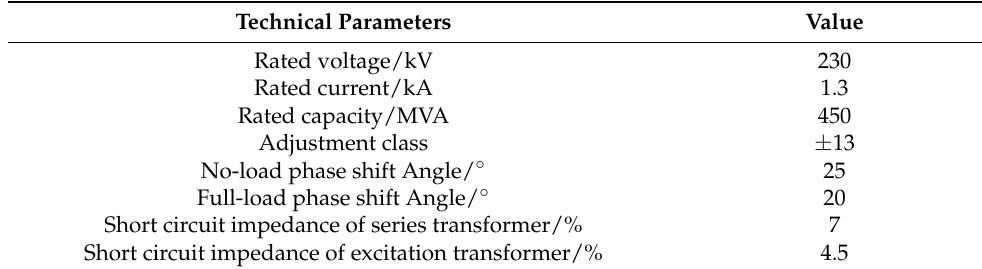
Table 2. Technical parameters of 220 kV PST .